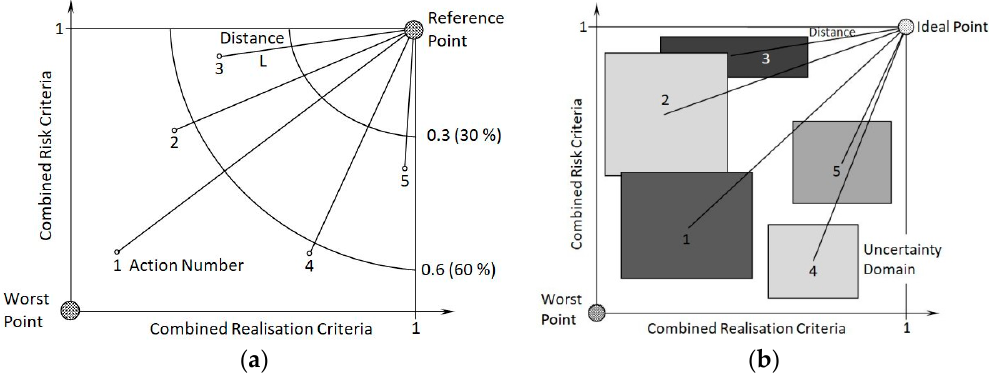
Figure 1. ( a ) Illustration of the composite distance for the case of no uncertainty in the actual values of the indicators and ( b ) risk management under uncertainty (minimum distance = “best” action).